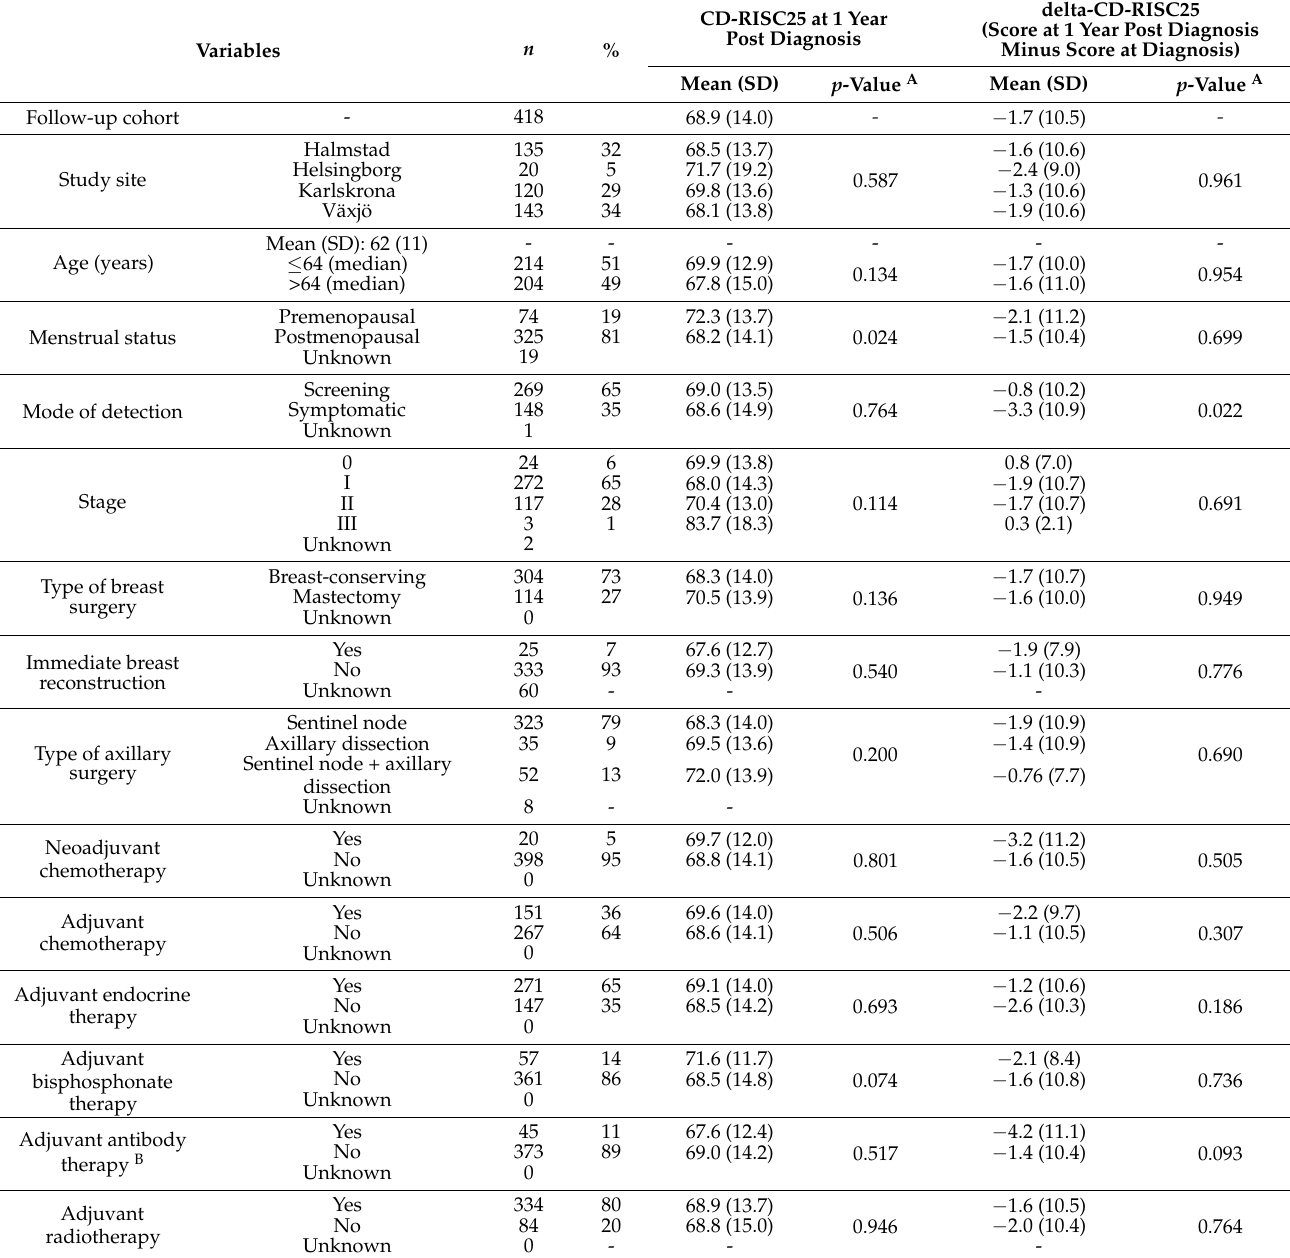
Table 1. Mean score for psychological resilience (CD-RISC25) at 1 year post diagnosis, and mean change in psycho- logical resilience score between 1 year post diagnosis and diagnosis (delta-CD-RISC25) according to demographic and clinicopathological